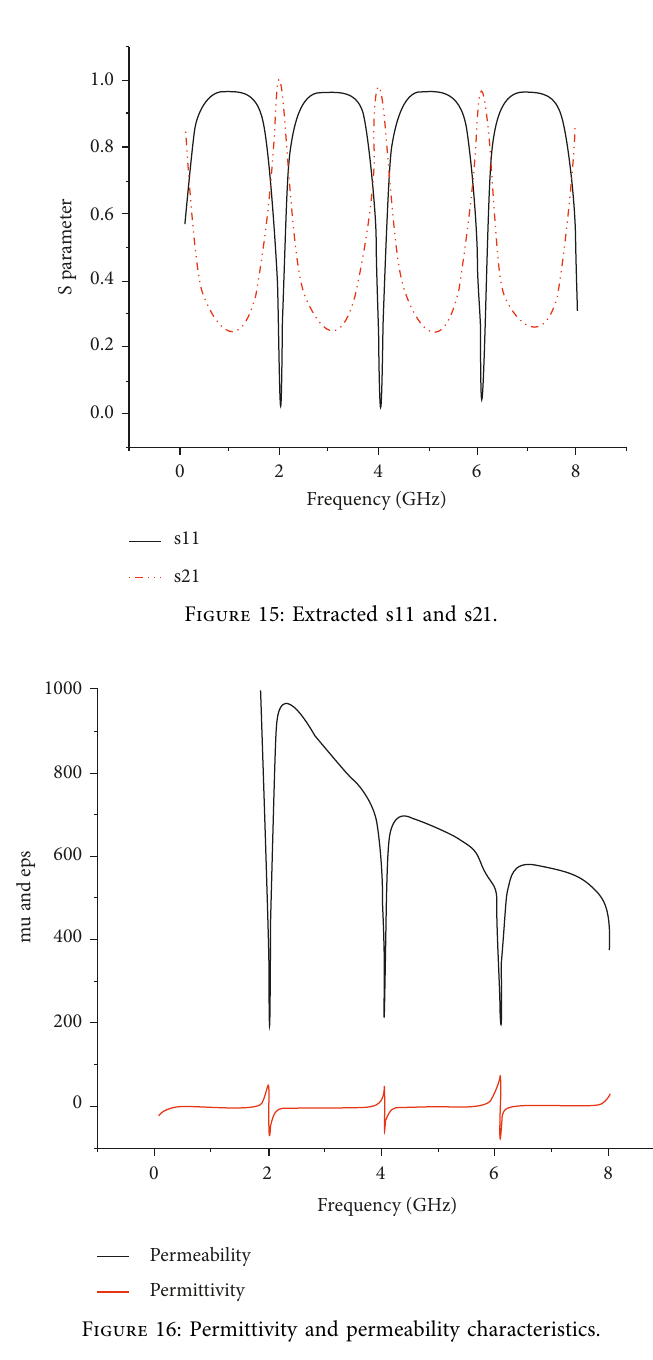
Figure 16: Permittivity and permeability